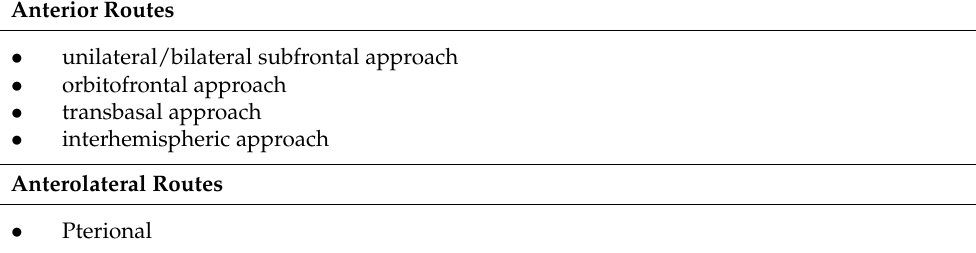
Table 1. Definition of the surgical